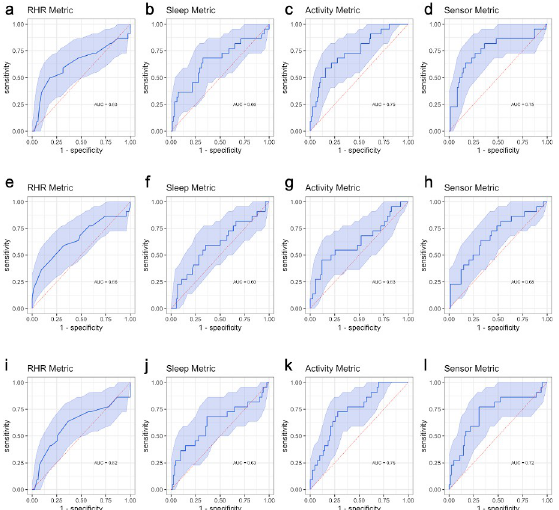
Fig 2. AUCs based on RHR, sleep, activity and all-sensor metric derived from wearable sensors to differentiate symptomatic subjects who were tested positive and negative corresponding to data schemes I-III. ( a-d ): Scheme I —all data; ( e-h ) Scheme II—remove data on and after knowing the test results; ( i-l ): Scheme III—remove data since symptom onset and before the test results. For each data scheme in the row, the four panels are for RHR, sleep, activity and sensor metrics,